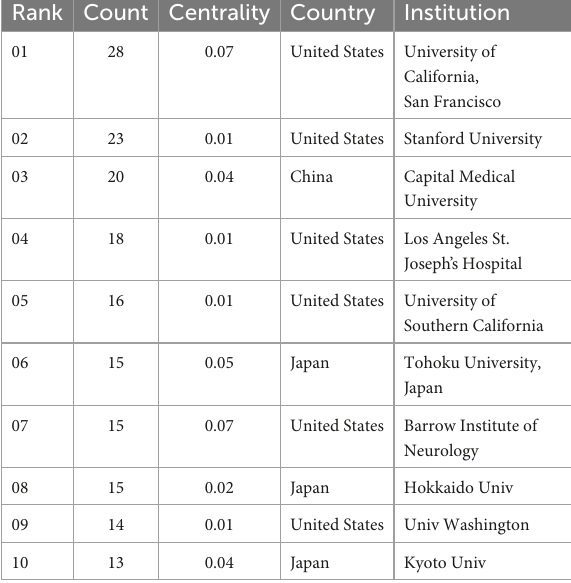
TABLE 3 Ranking of institutions with the largest number of publications (top 10). Rank Count Centrality